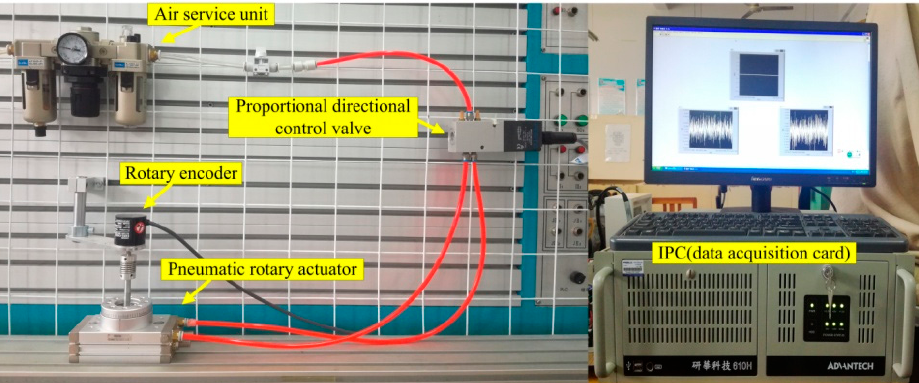
Figure 8. Experimental platform of the pneumatic rotary actuator servo system.